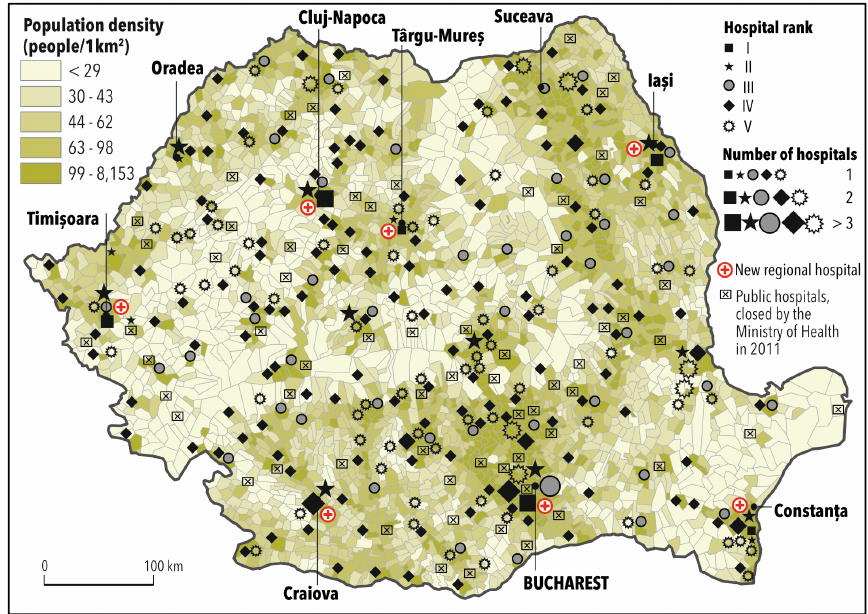
Figure 1. Distribution of hospitals according to the level of competency (2011).